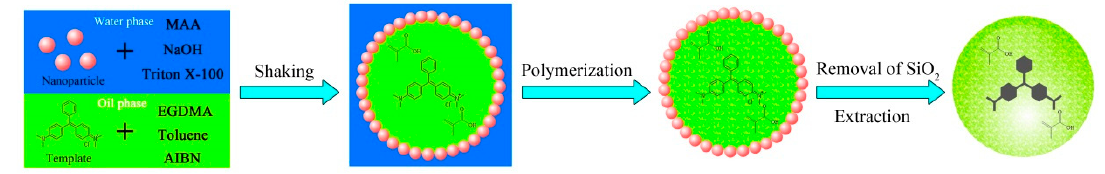
Figure 1. Schematic illustration of the synthesis of M-PMs by Pickering emulsion polymerization and molecular imprinting.